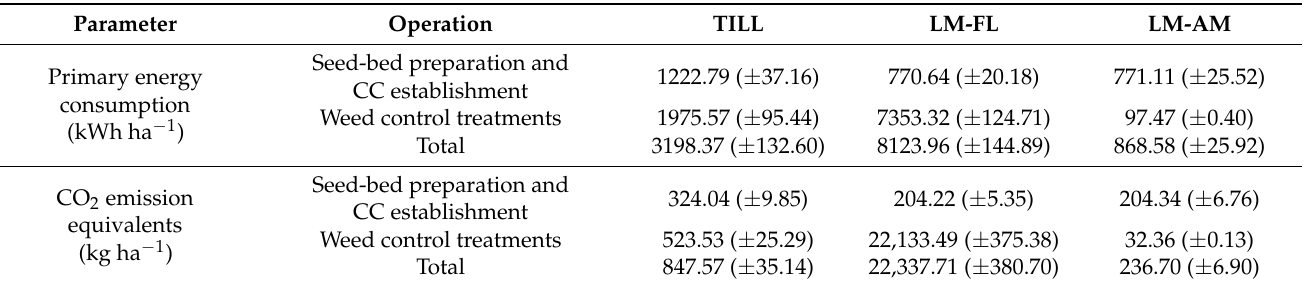
Table 4. Estimation of primary energy consumption and CO 2 emission equivalents for the different vegetable management systems during the two years of the